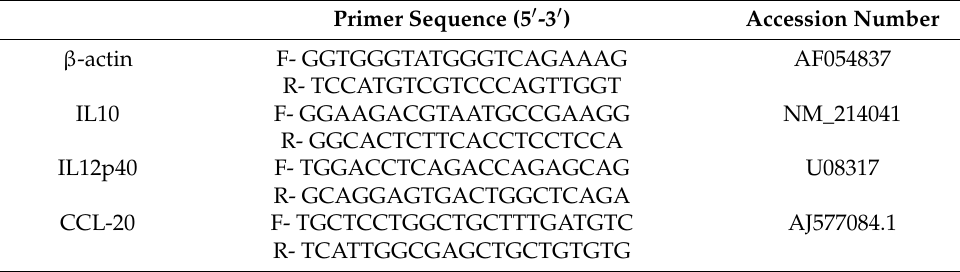
Table 1. Primer sequences of cytokines,